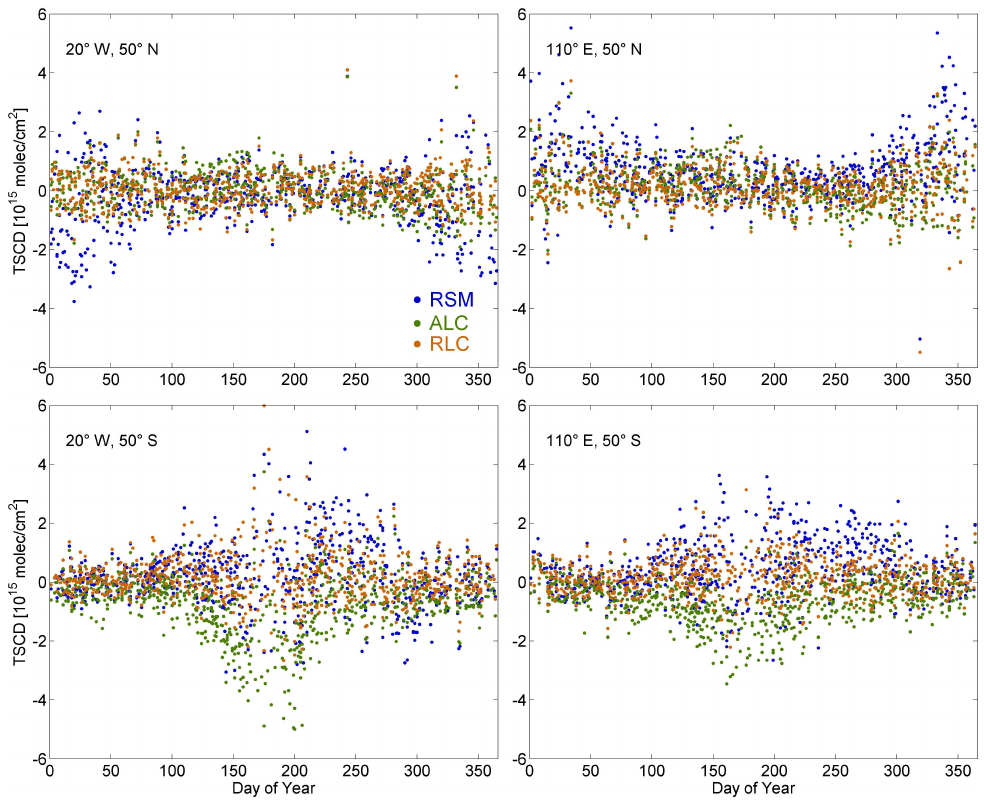
Fig. 11. Annual cycle of TSCDs for four selected locations (as marked in Figs. 6–10). Upper row: 50 ◦ N. Lower row: 50 ◦ S. Left column: 20 ◦ W. Right column: 110 ◦ E. The different schemes are marked by colors: blue ( T RSM ), green ( T ALC ), and orange ( T RLC